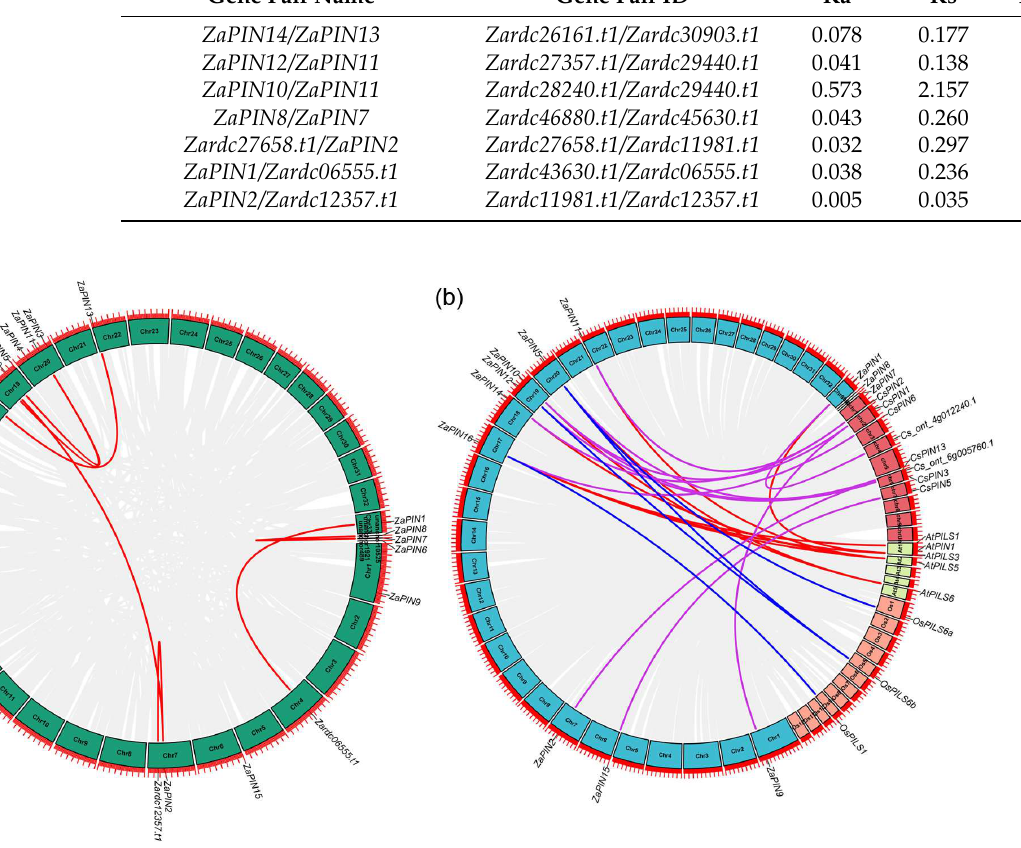
Figure 6. Chromosome distribution and synteny analysis of PINs . ( a ) Chromosome distribution and synteny analysis of ZaPINs . ( b ) Collinearity analysis of PIN members between Z. armatum and different species. Z. armatum , Arabidopsis , rice, and C . sinensis chromosomes are depicted as differently colored boxes. Collinearity relationships between PIN regions are represented by differently colored lines. Blue, ZaPINs to OsPINs ; Red, ZaPINs to AtPINs ; purple, ZaPINs to CsPINS. To further elucidate the evolutionary history of ZaPINs, we conducted a collinearity analysis of PIN genes between Z. armatum and the genomes of C. sinensis , A. thaliana , and